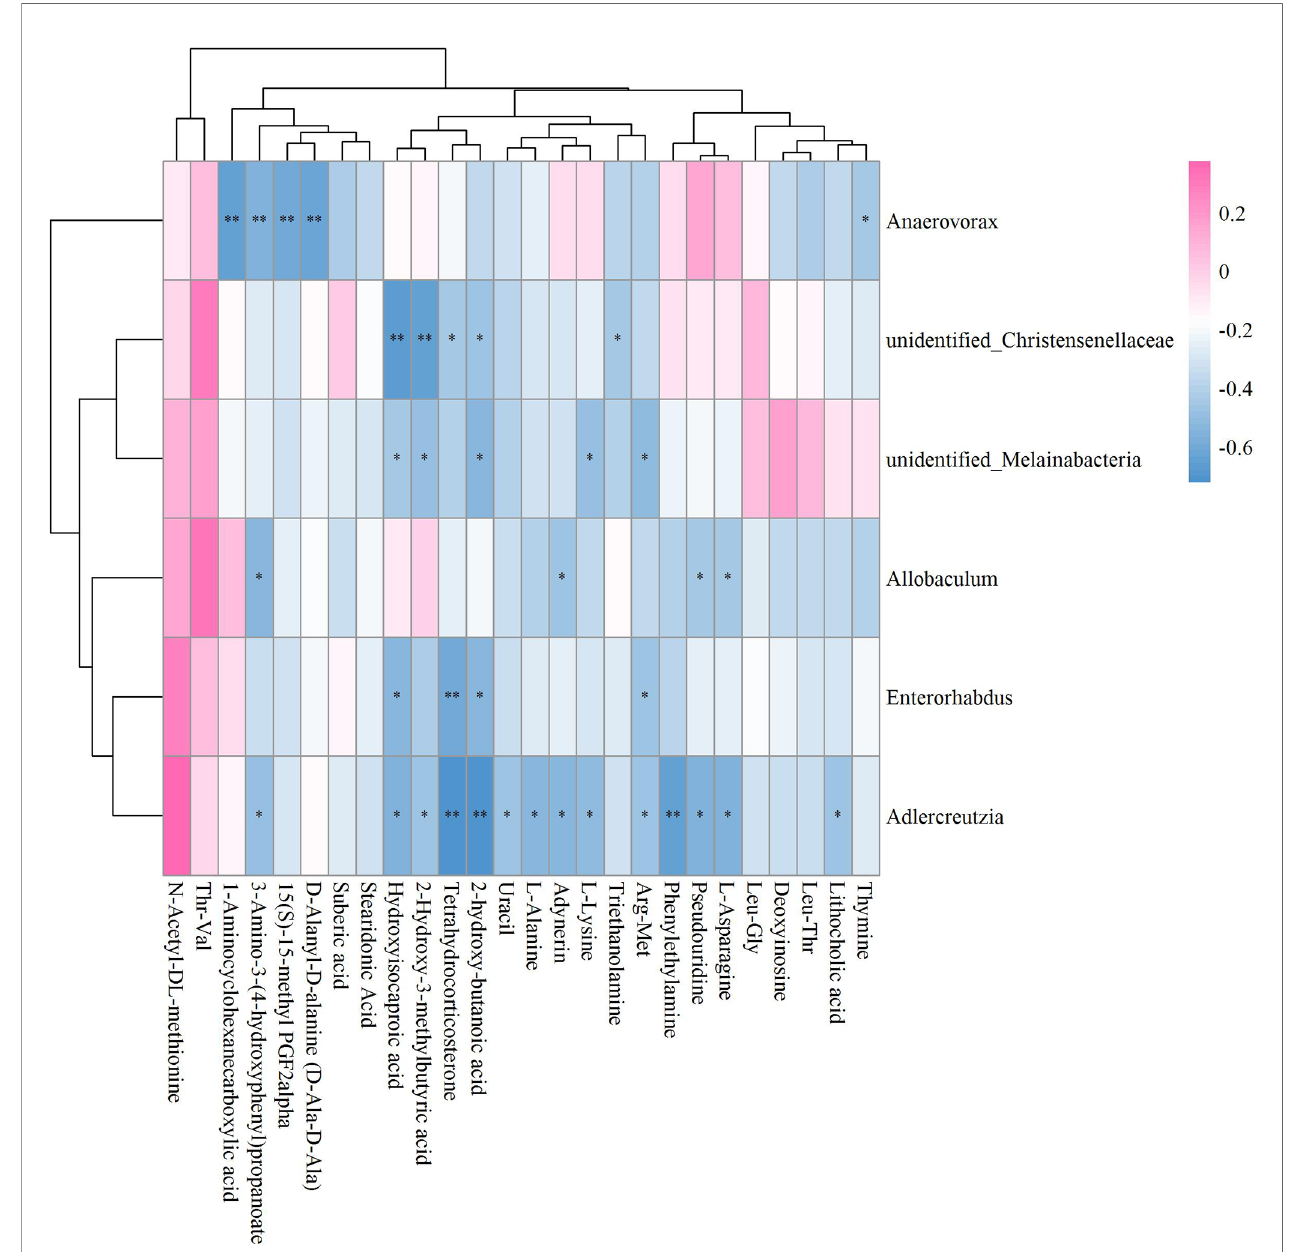
FIGURE 9 | Hierarchical clustering heat map of the signi fi cant differential GM and fecal metabolites in OVX+E2 and OVX groups based on Spearman correlation analysis (n = 10). * and ** mean a signi fi cant correlation between GM and fecal metabolites was found based on p < 0.05 and p < 0.01,